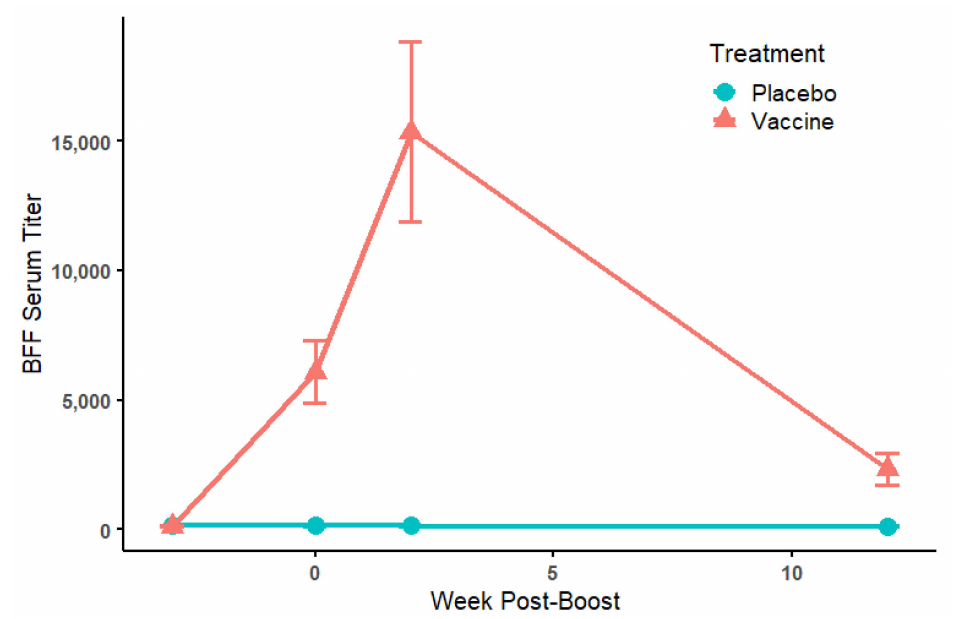
Figure 2. Mean black-footed ferret (BFF) anti-SARS-CoV-2 serum titers as measured by enzyme- linked immunosorbent assays (ELISA) by week post-boost. Error bars represent the standard error of the mean. BFF were vaccinated at week − 3 and 0, with titers increasing after both prime and boost vaccinations and peaking at 2–3 weeks post-boost. No change in titer was observed in control animals receiving a placebo (blue line; circles). For the purposes of visualization, animals that were bled at 2 or 3 weeks post-boost were grouped here as a single data point.